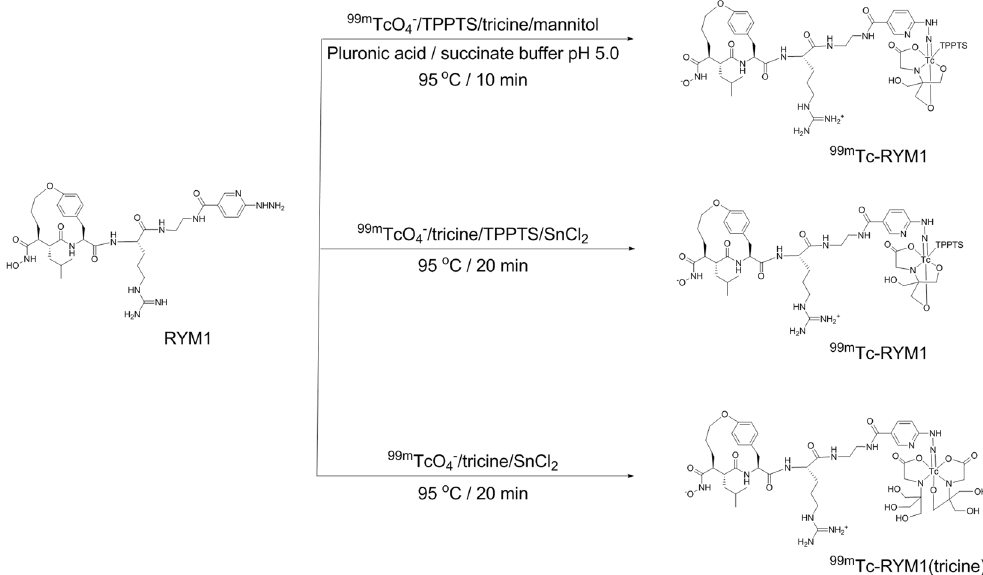
Figure 6. 99m Tc-labeling of RYM1 using 3 different